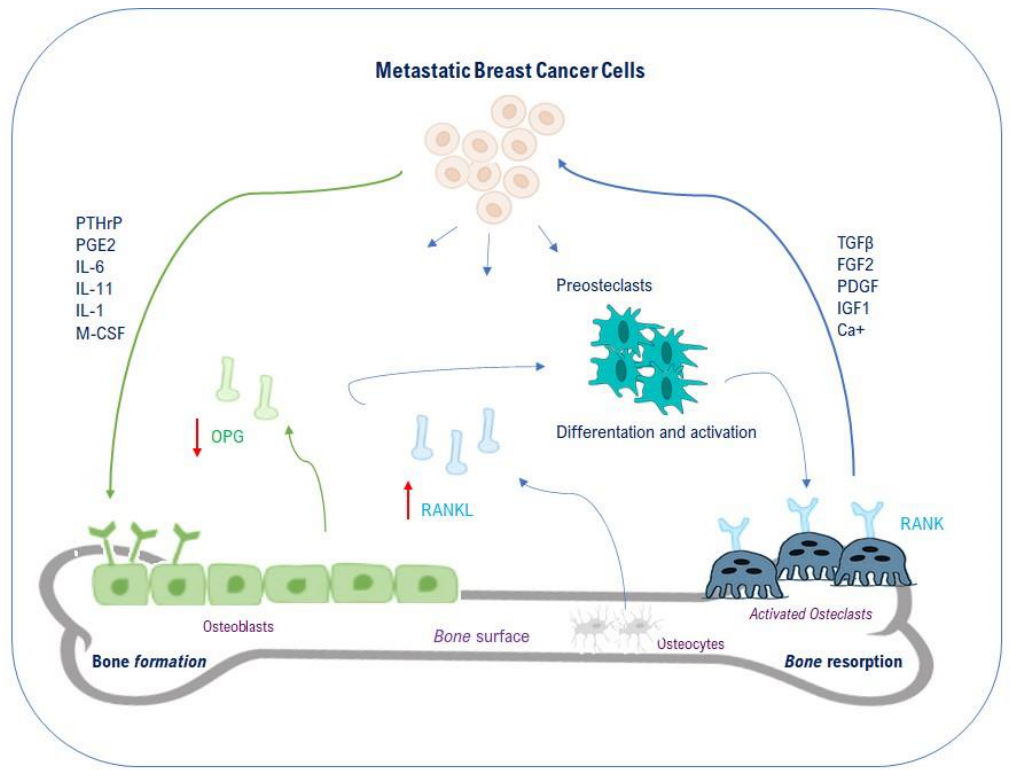
Figure 2. Schematic representation of vicious cycle between cancer cells and bone. Cancer cells secrete soluble factors (PTHrP, PGE2, ILs, M-CSF), which act on osteoblasts and osteoclasts in bone metastatic site. RANKL production is increased and OPG secretion is decreased from osteoblasts; OPG in physiological conditions acts as a decoy receptor binding the excess of RANKL. The up-regulated RANKL interacts with RANK receptor on preosteoclast. Preosteoclasts respond with their di ff erentiation and osteolytic activation: PDGFs, BMPs, TGF- β , IGF1, and calcium ions released by degraded bone matrix can further enhance tumor cells survival. These cells produce more PTHrP which, in turn, reinforces bone resorption. Red arrows indicate the increase or decrease of molecules’ levels. Blue arrows suggest the relationship between different components of the vicious cycle.